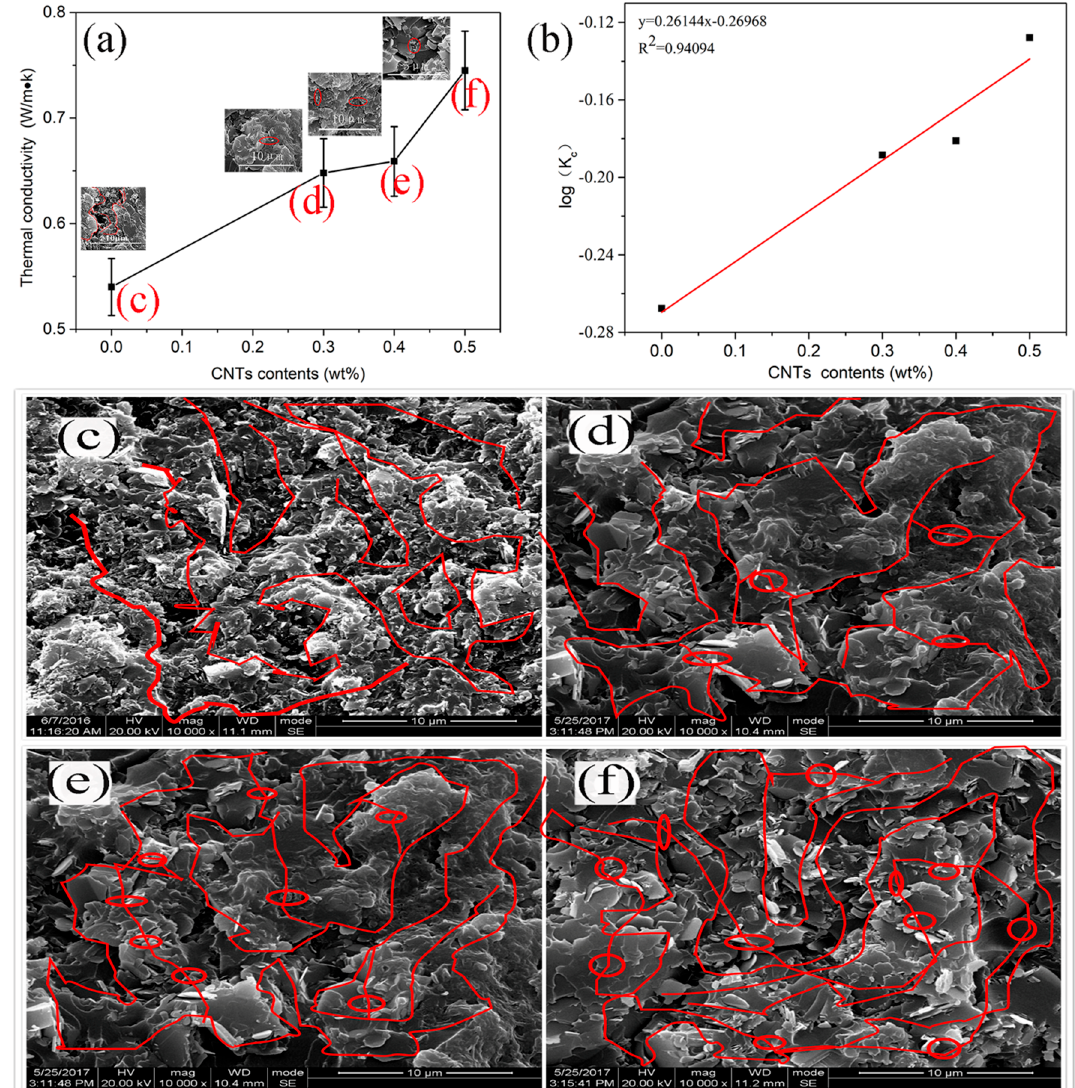
Figure 4. The thermal conductivity of h-BN/ f -CNTs reinforced composites: ( a ) the content of f -CNTs affecting on ƛ value of resin matrix composites; ( b ) logarithmic plot of ƛ values with respect to the content of f -CNTs (Agari’s model); ( c ) microphotographs of h-BN reinforced composites; ( d ) h-BN/ f - CNTs reinforced composites with 0.3 wt% f -CNTs; ( e ) with 0.4 wt% f -CNTs and ( f ) with 0.5 wt% f - CNTs.